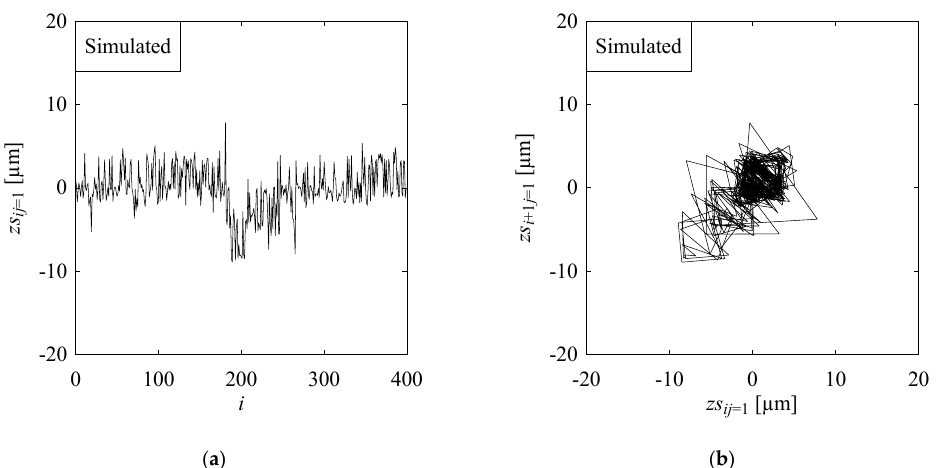
Figure 7. Outcomes of discrete event Monte Carlo simulation-based SC associated with Markov chain-based MC: ( a ) simulated surface heights; ( b ) return map of ( a ).